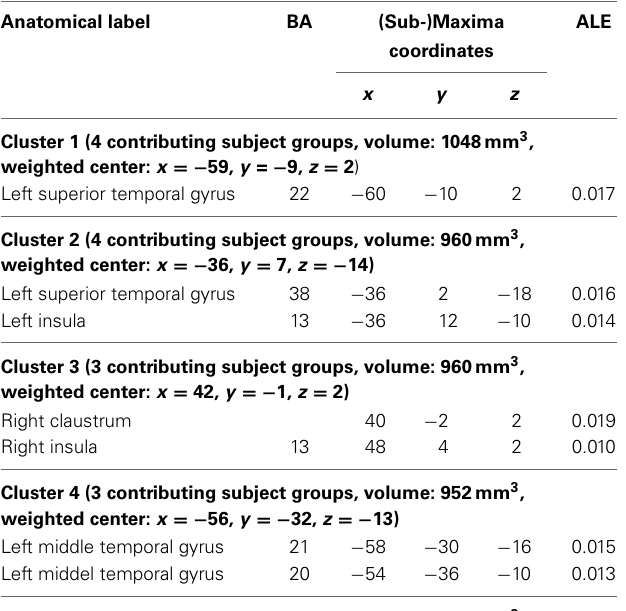
Table 3 | Brain areas (cluster-information and peak voxels) with significant convergence across studies in Group A (mainly decreased connectivity/activity in depression).